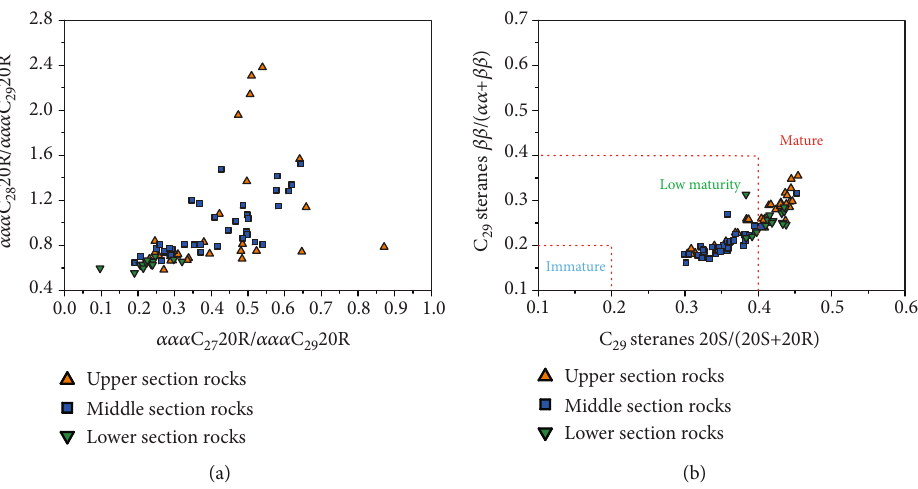
ααα 20R vs. C ααα 20R sterane plot used to identify the organic matter inputs. /C /C 28 29 27 29